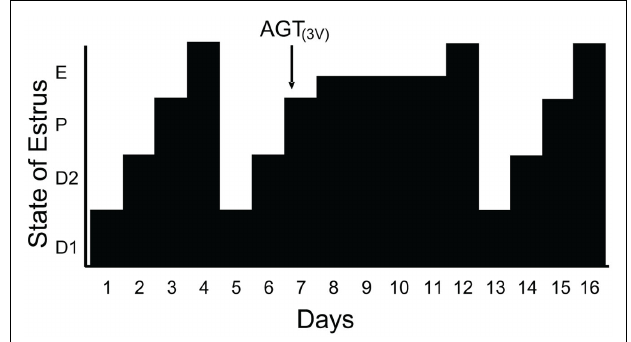
FIGURE 1 | Blocking neuroprogesterone synthesis alters the pattern of estrous cycles in gonadally intact rats. The 4-day rat estrous cycle is diagrammatically presented. Each day of the cycle is indicated on the ordinate: D1, diestrous day 1; D2, diestrous day 2; P, proestrus; and E, estrus. Neuroprogesterone synthesis was blocked by infusion of a P450scc inhibitor, aminoglutethimide (AGT), into the third ventricle (3V) via an implanted cannula. All animals treated with DMSO (5%, vehicle n = 14; data not shown) had normal 4day estrous cycles as determined by vaginal cytology. In contrast, 11/14 AGT treated rats (0800hours on proestrus, indicated by the arrow) had disrupted estrous cycles with delayed onset of estrous as determined by vaginal cytology (from Micevych and Sinchak,